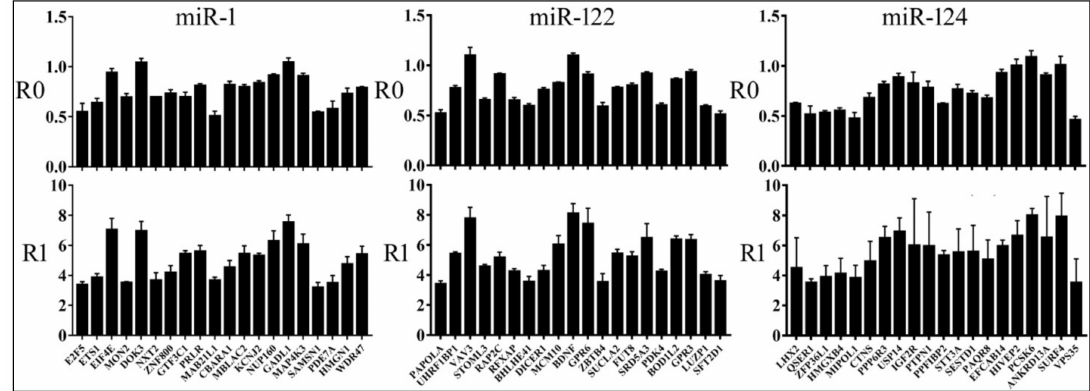
Figure 2. Results of reporter assays in 293T cells. Averages and standard deviations of R0 and R1 values ( y -axes) are shown for the individual genes listed at the bottom ( x